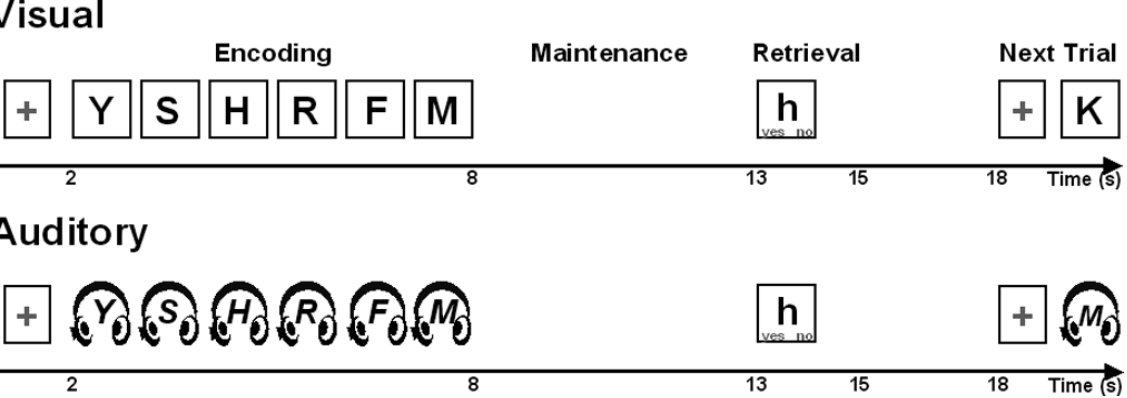
Fig. 1. Task design for investigating modality-dependent VWM activation. Two to six target letters during the encoding phase of the task were presented sequentially in the center of a visual display (visual modality) or binaurally through headphones (auditory modality). Subjects pressed a yes or no button to indicate whether the probe letter matched one of the presented